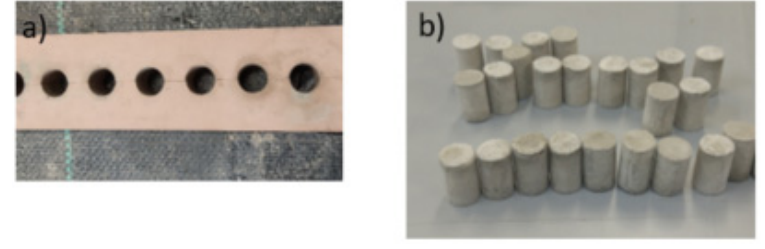
Figure 2. ( a ) Molds used to obtain specimens; ( b ) cylindrical